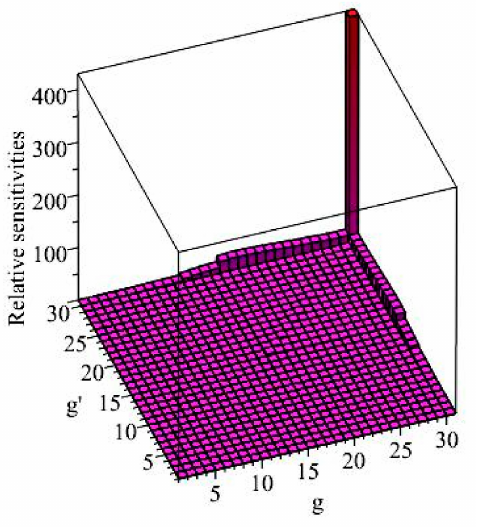
(cid:16) (cid:17) (cid:48) σ g , σ g , g , g (cid:48) = 1, ... ,30, for 1 t , i = 6 t , k = 6